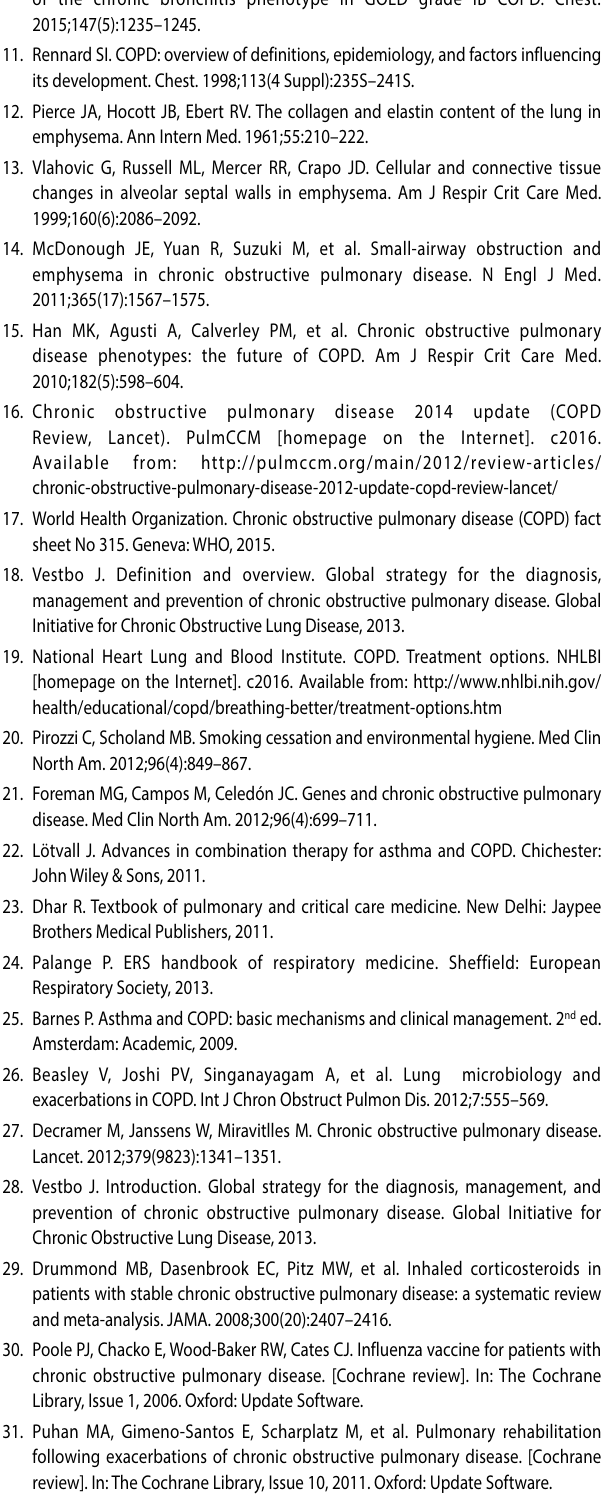
The page number in the footer is not for bibliographic